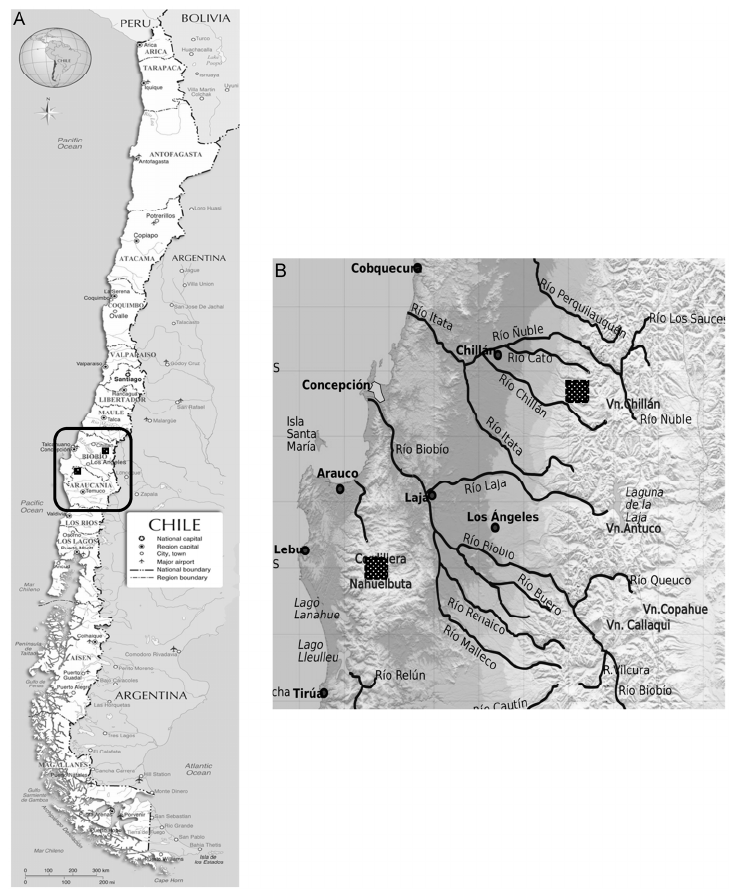
Figure 1. Map of Chile ( A ) and location of the Biobío and Araucanía Regions (insert); ( B ) location of Los Pellines and Chanleo Sectors (upper and lower white-dotted squares, respectively)